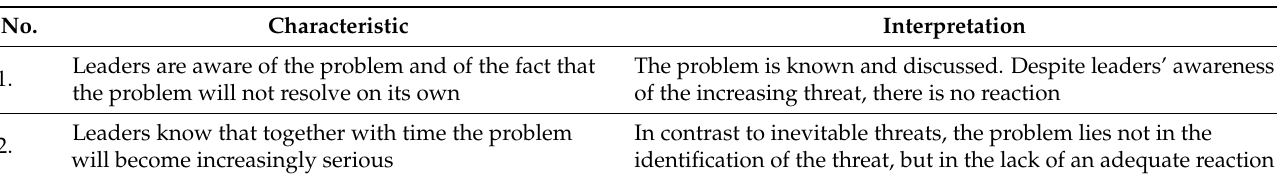
Table 1. Six characteristic features of predictable